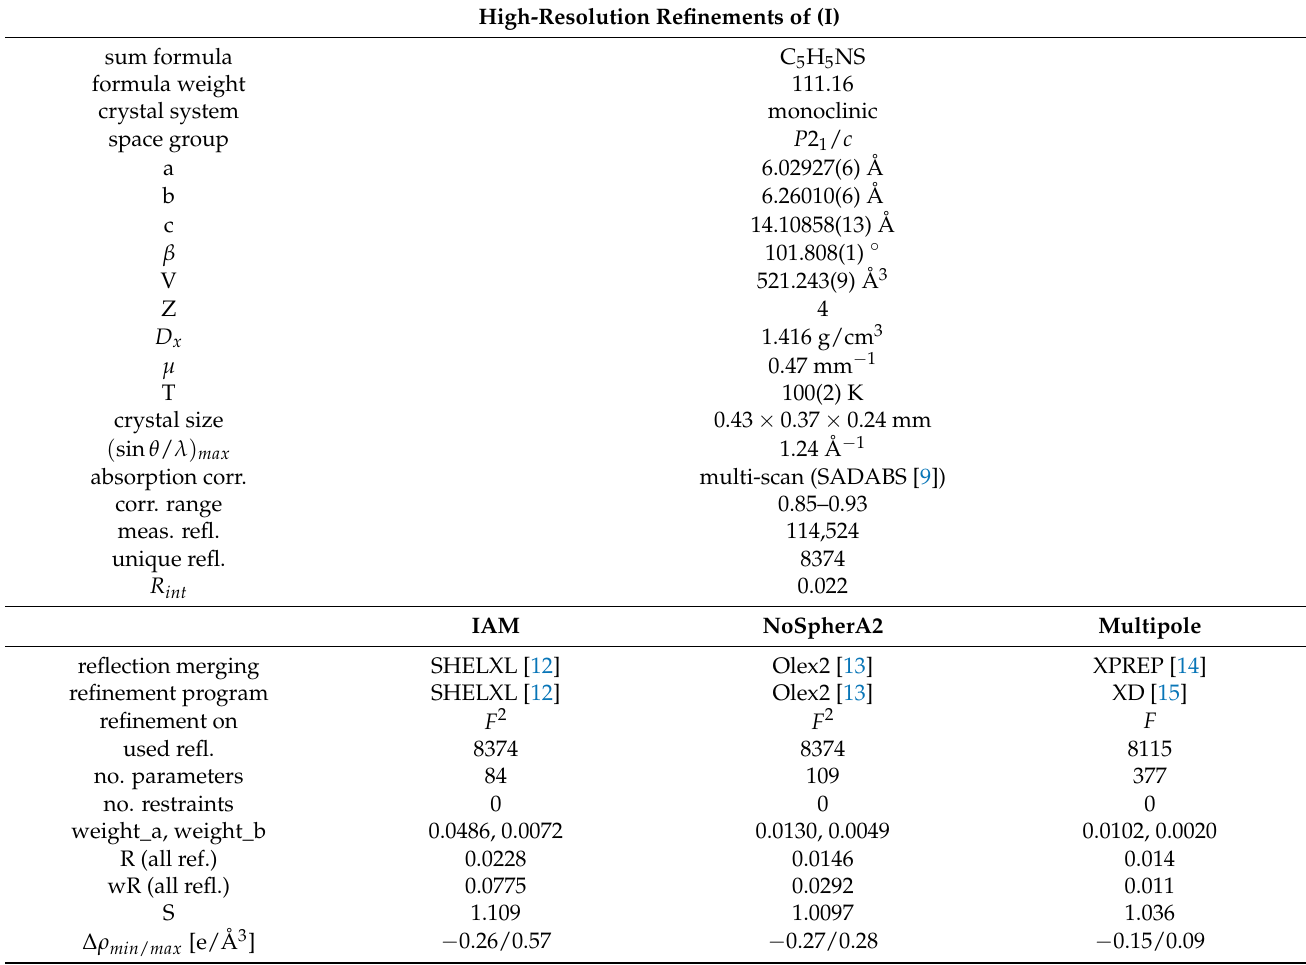
Table 1. Experimental